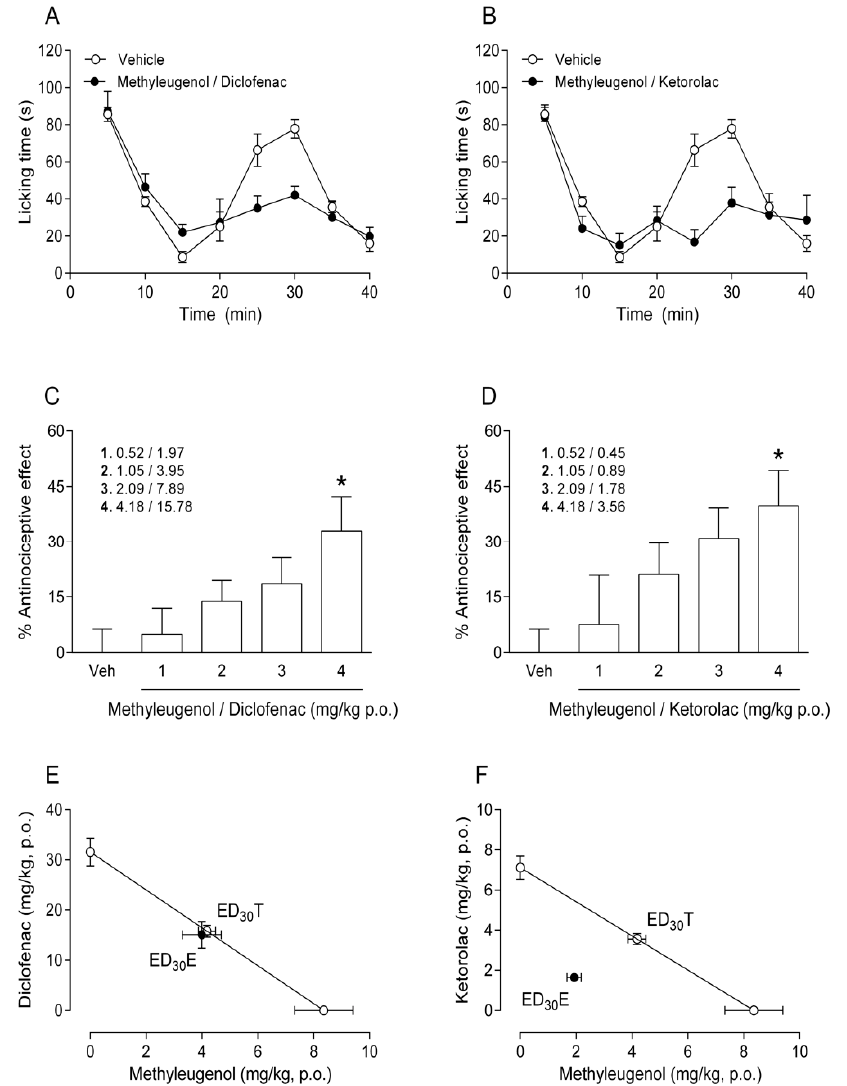
Figure 2. The time course of the antinociceptive effect induced by methyleugenol plus diclofenac ( A ) or methyleugenol plus ketorolac ( B ), evaluated by the formalin test. The dose-response effects of the vehicle (Veh), methyleugenol plus diclofenac ( C ), and methyleugenol plus ketorolac ( D ). Bars illustrate the mean of the percentage of antinociception ± SEM for 6–8 animals. * p < 0.05 versus the Veh group, determined by one-way analysis of variance (ANOVA) followed by Tukey’s test. The isobolographic interaction of methyleugenol plus diclofenac ( E ) or methyleugenol plus ketorolac ( F ) at a 1:1 dose ratio. The points on the X -axis portray the experimental ED 30 values of methyleugenol and those on the Y -axis the experimental values of diclofenac or ketorolac. The diagonal line connecting the ED 30 of the combination of methyleugenol and diclofenac or ketorolac is the theoretical value of additivity. For each combination, the point designated as ED 30 T represents the theoretical ED 30 , and the point labelled ED 30 E indicates the experimental ED 30 for each combination. The ED 30 E was statistically different from the ED 30 T for methyleugenol plus ketorolac but not for methyleugenol plus diclofenac. Differences were examined with the Student’s t -test, considering significance at p < 0.05.